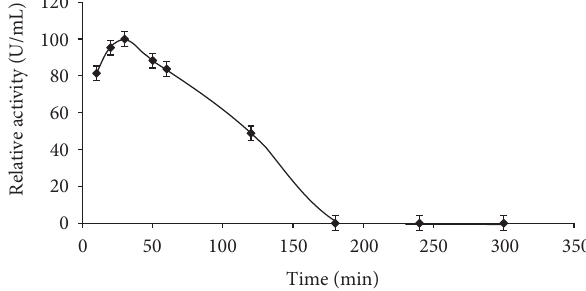
F 9: Temperature stability of F. solani PHB